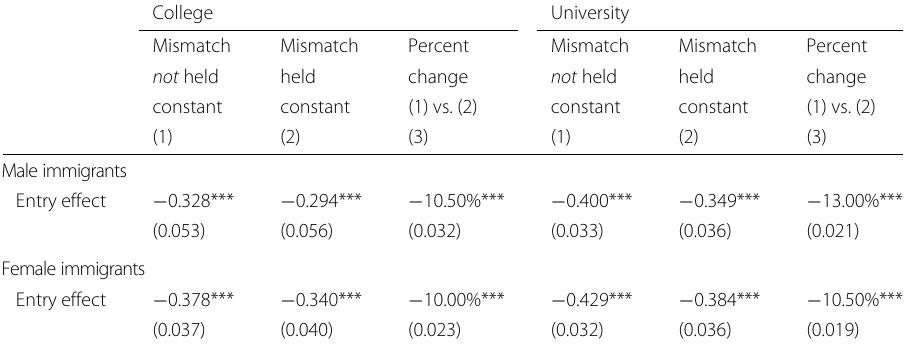
Table 10 Percent of entry effect due to mismatch: college vs. university (non-traditional